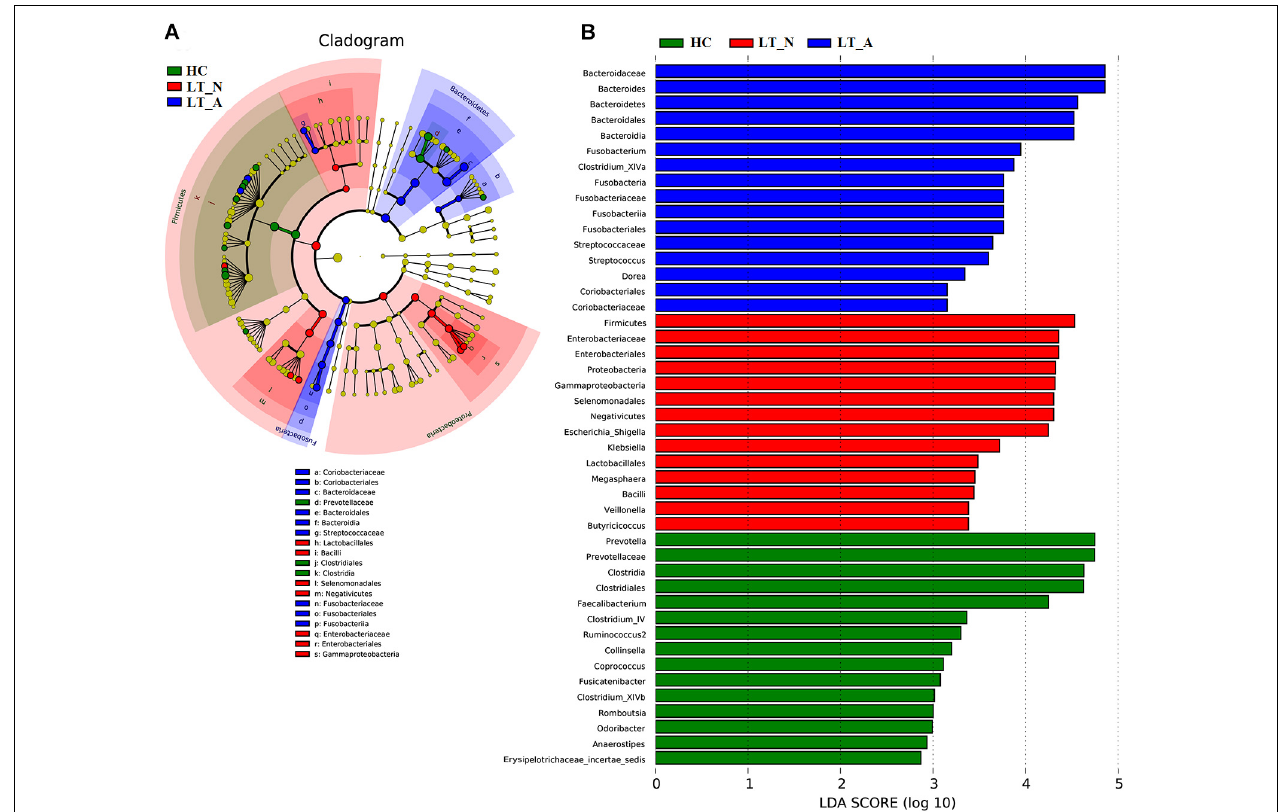
FIGURE 5 | LEfSe and LDA based on divergent OTUs between the fecal microbiomes of the LT_A, LT_N, and HC groups, which identified the most differentially-abundant taxa between the three groups. (A) Taxonomic cladogram generated using the LEfSe method. LT_A-enriched taxa, blue; LT_N-enriched taxa, red; taxa enriched in healthy controls, green. (B) LDA scores indicating significant differences in microbiota between the three groups (LT_A, LT_N, and HC). HC-enriched taxa, green; LT_A-enriched taxa, blue; LT_N-enriched taxa, red. LT_A, fecal microbiomes of the liver recipients with abnormal liver function; LT_N, fecal microbiomes of the liver recipients with normal liver function; HC, fecal microbiomes of the healthy control group; LEfSE, linear discriminant analysis effect size; LDA, linear discriminant analysis; OTU, operational taxonomic unit.